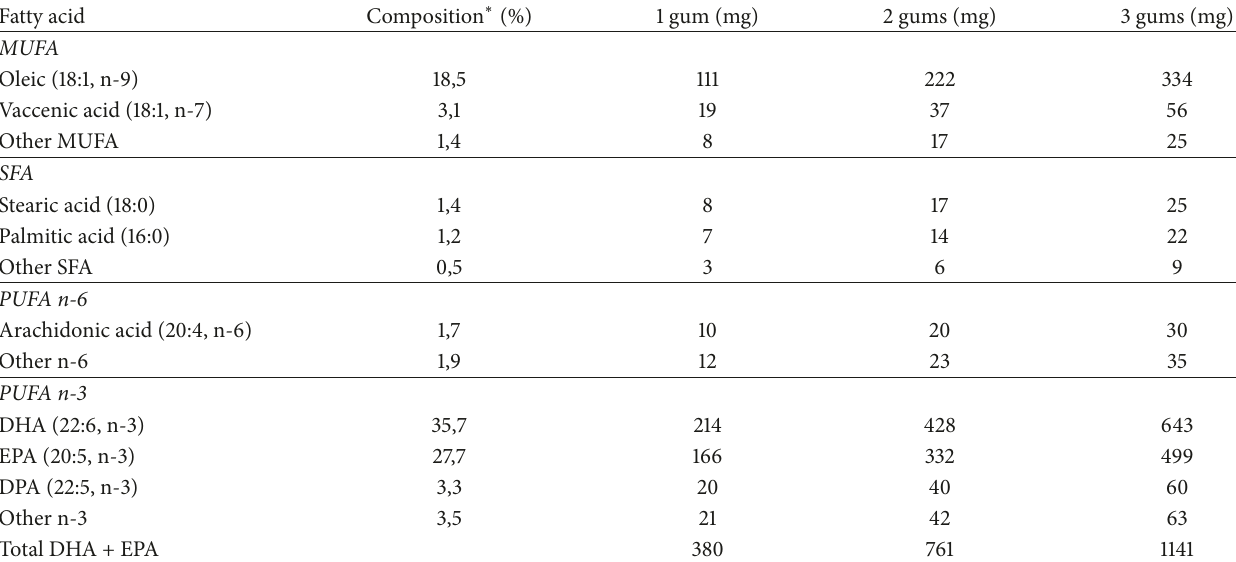
Table 1: Fatty acid composition of the diet supplement